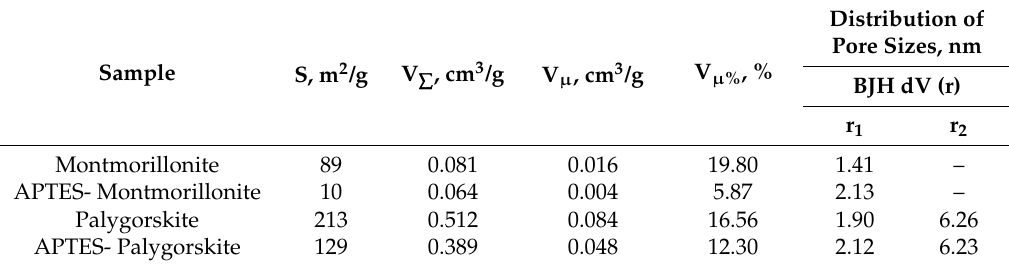
Figure 5. Mesopore-size distributions for pristine and APTES-modified in toluene clay minerals. Table 1. Surface characteristics of pristine and APTES-modified in toluene clay minerals.